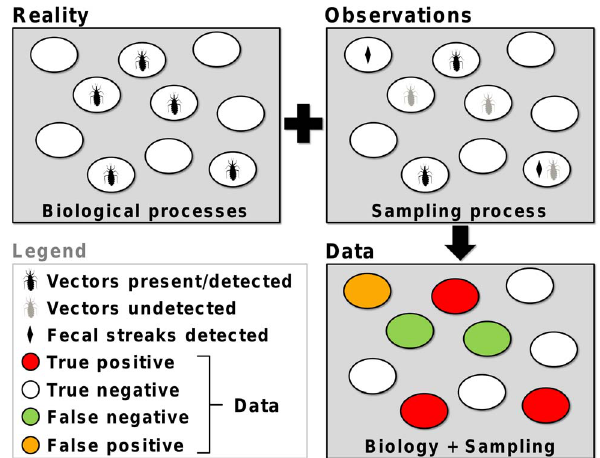
Figure 4. Full reality is only partially observed. Imagine a survey in which 10 discrete ecotopes, five of which are infested (‘‘Reality’’), are searched for vectors or their traces. During the survey (‘‘Observations’’), the vectors went undetected in two infested ecotopes; non-vector fecal streaks were misidentified as vector feces in one ecotope; vectors were detected in two infested ecotopes; vector fecal streaks were correctly identified in a third infested ecotope where no vectors were detected; and no detections occurred in four non-infested ecotopes. The resulting dataset (‘‘Data’’) is therefore a biased representation of reality – it contains one false-positive detection and two false-negative results, along with three true-positive and four true-negative results.